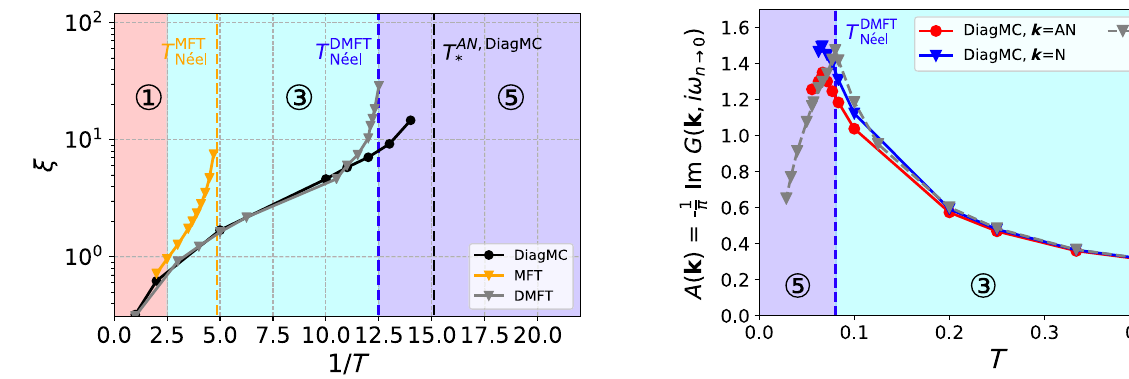
FIG. 7. Magnetic correlation length as a function of (inverse) temperature for DiagMC, MFT, and DMFT on a logarithmic scale.